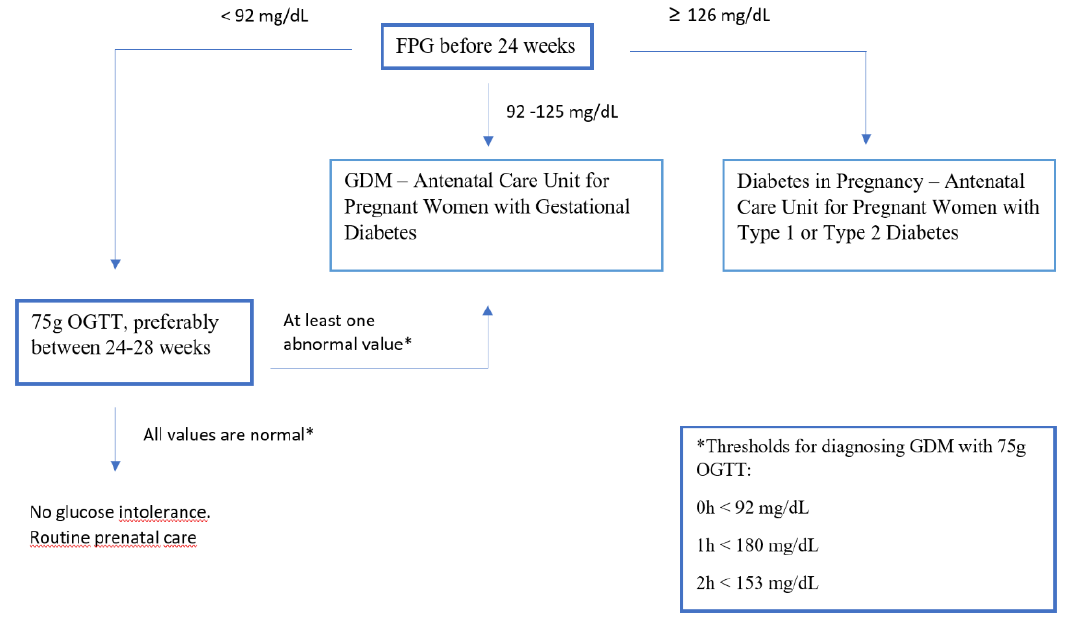
Figure 1. Diagnostic and follow – up flowchart for patients seen in the Obstetrics Department of Hos-